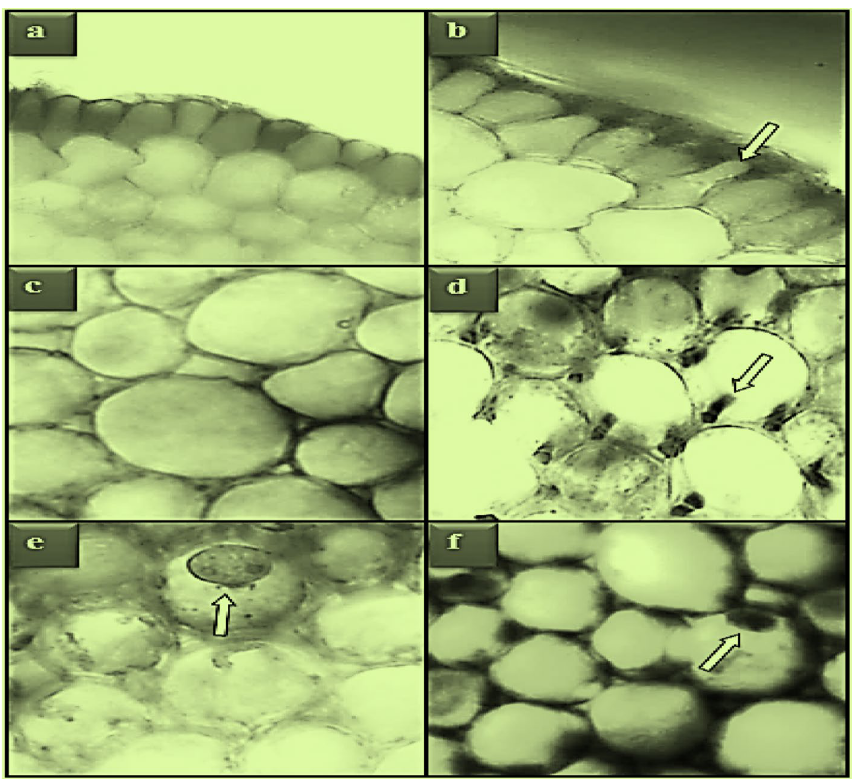
Figure 7. Meristematic cell damage induced by KBrO 3 . Normal appearance of epidermis cells ( a ), epidermis cell damage ( b ), normal appearance of cortex cells ( c ), thickening of the cortex cell wall ( d ), normal appearance of the cell nucleus- oval ( e ), flattened cell nucleus ( f